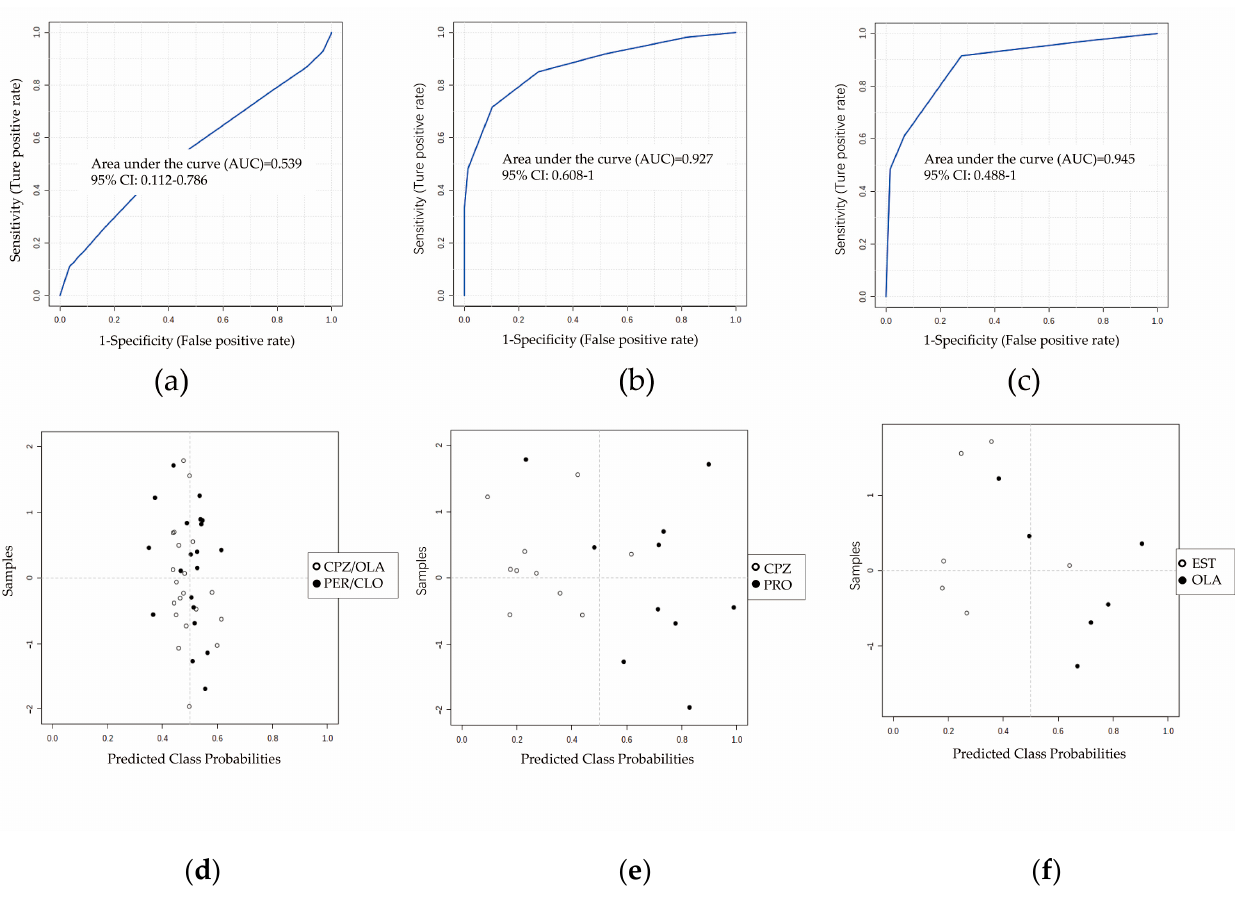
Figure 4. Differential performance of combinations of L-acetylcarnitine, succinic acid, and propionylcarnitine between antipsychotic groups and other groups of therapeutic drugs that led to fatal intoxication. ROC curves ( a – c ) and predicted class probabilities ( d – f ) show the differential performance and misclassification probabilities between antipsychotics and other therapeutic drugs. Discrimination with clozapine and perphenazine ( a , d ) was poor (AUC: 0.5; 95%CI of AUC: 0.1–0.8; n = 10), whereas that with promethazine ( b , e ; AUC: 0.9; 95%CI of AUC: 0.6–1; n = 10) or estazolam ( c , f ; AUC: 0.9; 95%CI of AUC: 0.5–1; n = 6) was better. Abbreviations: CLO: clozapine at a high dose that caused fatal intoxication; PER: perphenazine at a high dose that caused fatal intoxication; PRO: promethazine at a high dose that caused fatal intoxication; EST: estazolam at a high dose that caused fatal intoxication.